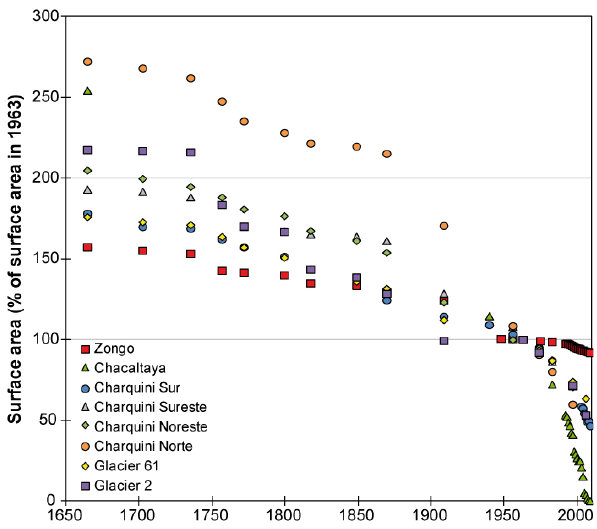
Fig. 3. Changes in the surface area of eight glaciers in the Cordillera Real, Bolivia, since the LIA maximum, reconstructed from moraine stages (LIA maximum and before 1940) and aerial photographs (1940 and after). 1963 was chosen as the common reference. Data are from Rabatel et al. (2006, 2008a) and Soruco et al.